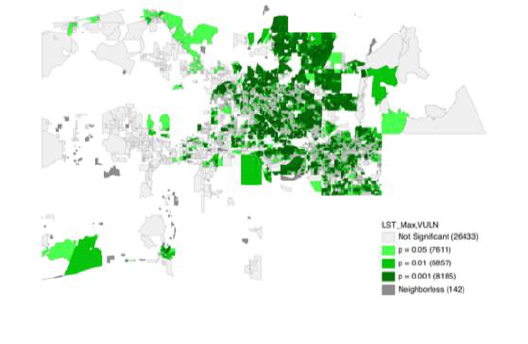
Figure 15 - Bivariate Local Moran’s I spatial autocorrelation cluster and significance maps for maximum LST versus socio- economic vulnerability for